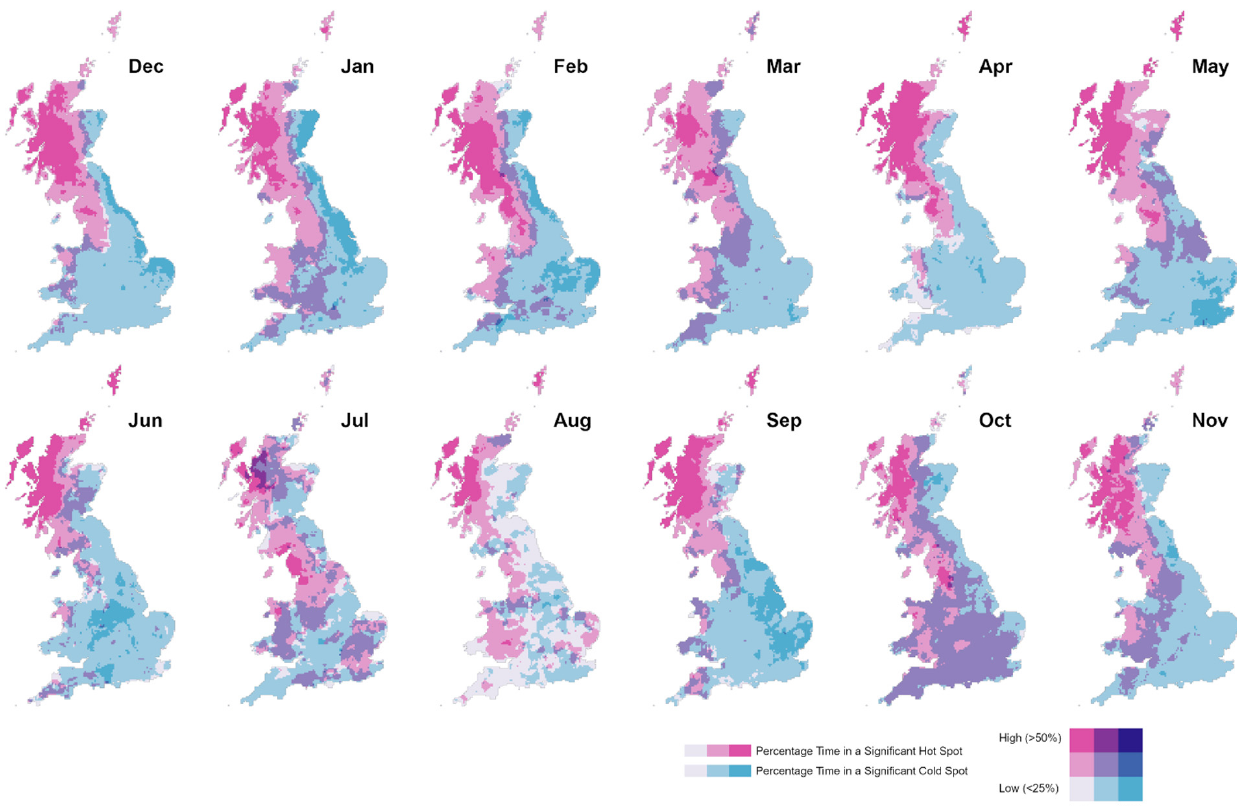
Figure 4. Space-time hot spot results under NAO+ conditions. Pinks indicate where the percentage of time in a significant hot spot is high (indicating wetter conditions), and light blues where the percentage of time in a significant cold spot is high (indicating drier conditions). Light grey indicates low occurrence of both hot and cold spots, whilst mixed shades indicate occurrence of both hot and cold spots. Disaggregated versions of these maps can be found in Appendix A.